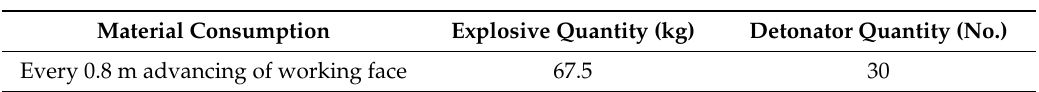
Table 2. Materials consumption of blasting.